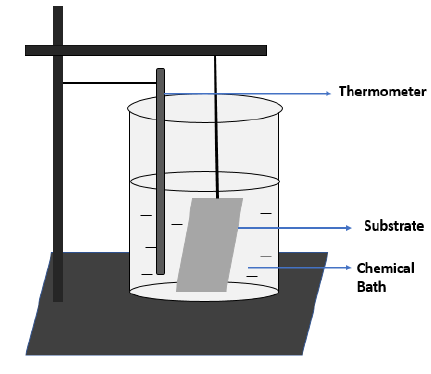
Fig. 1. Schematic of synthesis process